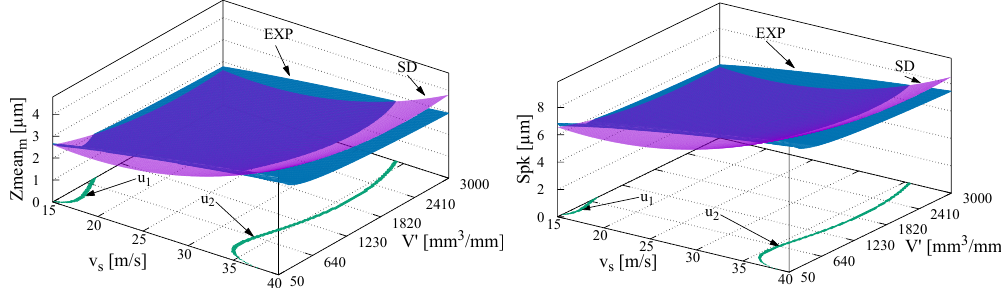
Figure 8. Dependence of Zmean_m and Spk on grinding speed v s as well as specific material loss V (cid:48) with a e = 18 µ m and v w =